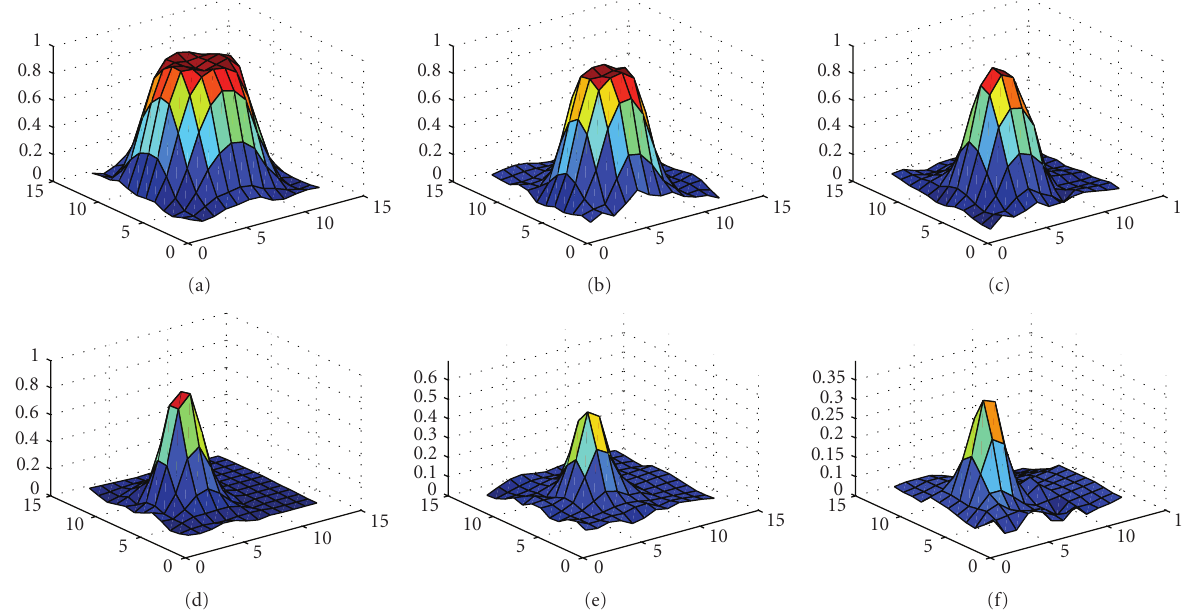
Figure 6: Segmented sphere surface plot for phantom data set 1. Voxel values scaled in [0..1] on Z axis, and voxels number is within [0..12] on X and Y axes: (a) sphere 1, (b) sphere 2, (c) sphere 3, (d) sphere 4, (e) sphere 5, and (f) sphere 6.